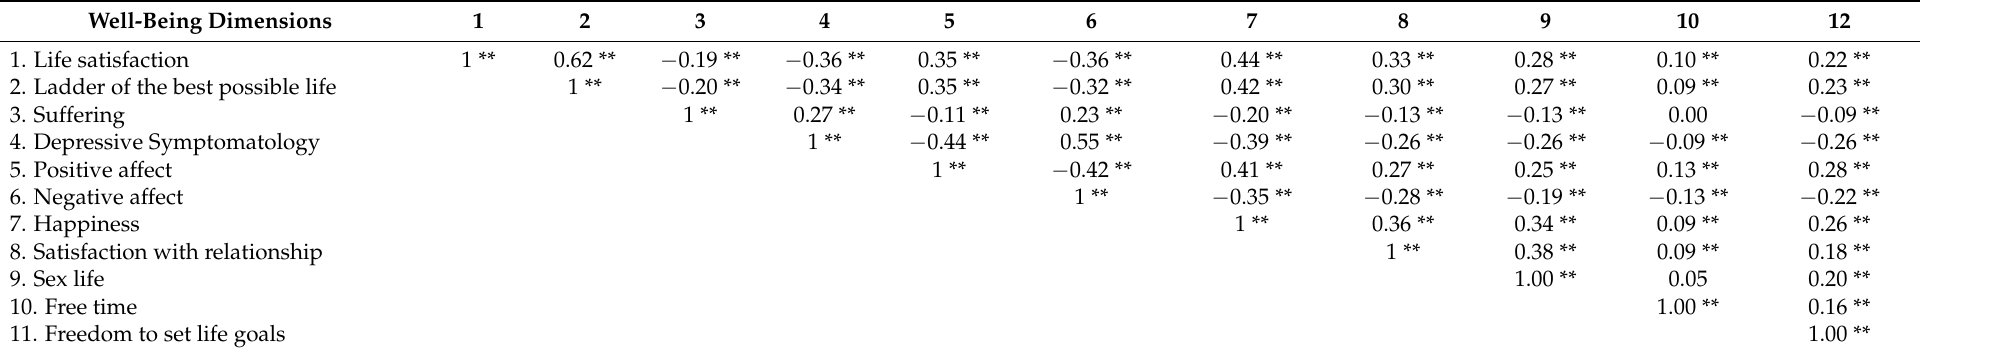
Table 2. Pearson’s correlation coefficients between the measured dimensions of